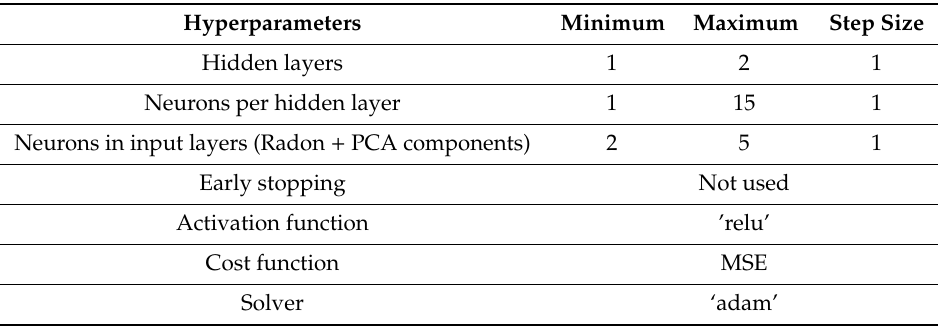
Table A2. Hyperparameters of the artificial neural network model used in this study. Hyperparameters